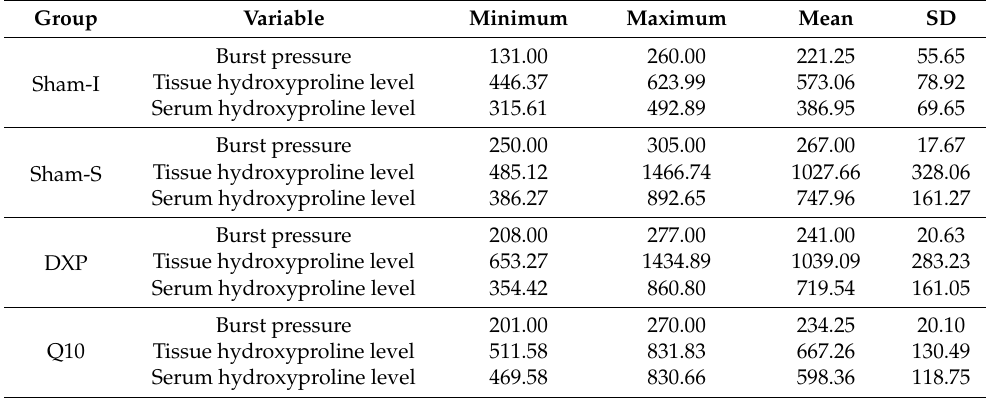
Table 2. Descriptive table of the burst pressure values and biochemical analysis results of all groups (SD: Standard deviation).